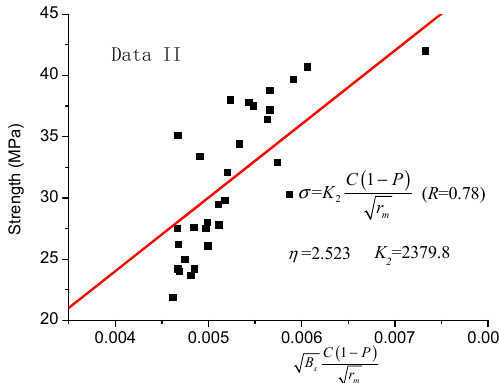
Figure 4. Equation (8) revised strength model (data II).